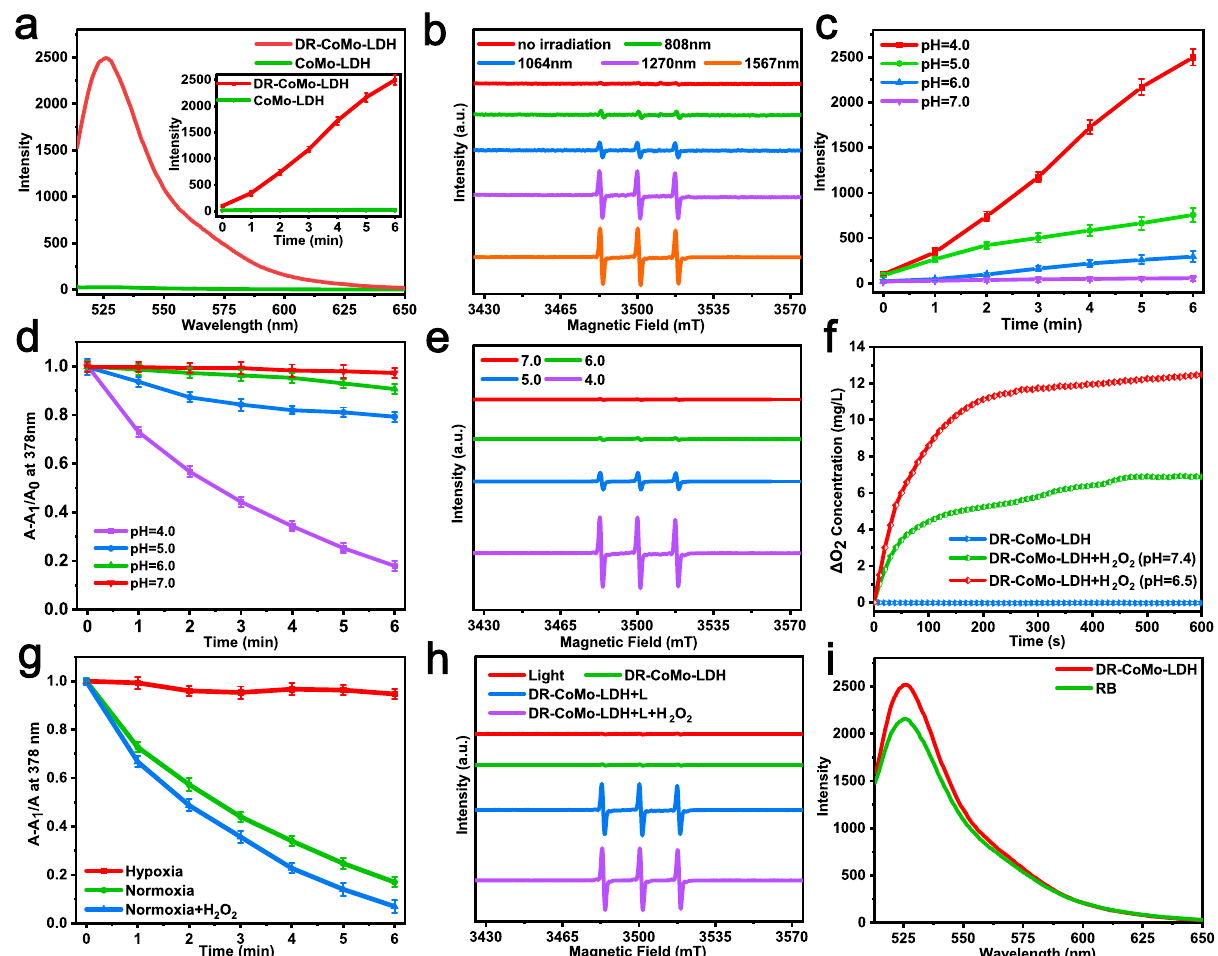
Fig. 3 Identi fi cation of 1 O 2 generation. a The fl uorescence intensity of SOSG in presence of the CoMo-LDH and DR-CoMo-LDH nanosheets in H 2 O under 1567 nm laser irradiation (0.5 W cm − 2 ). Data are presented as mean values ± s.d. ( n = 3). b ESR spectra of TEMP/ 1 O 2 for the DR-CoMo-LDH nanosheets in H 2 O under different-wavelength laser irradiation (0.5 W cm − 2 ) for 6 min. c The fl uorescence intensity of SOSG (in H 2 O) in presence of